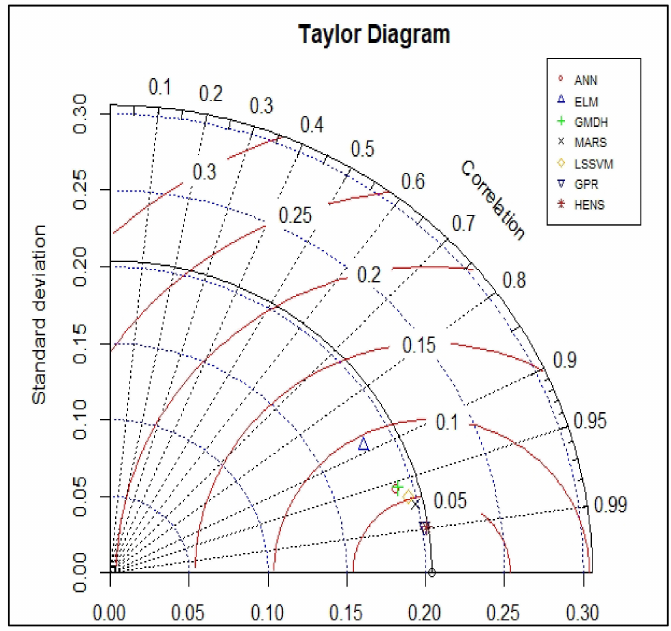
Figure 8. Taylor diagram of the training data.